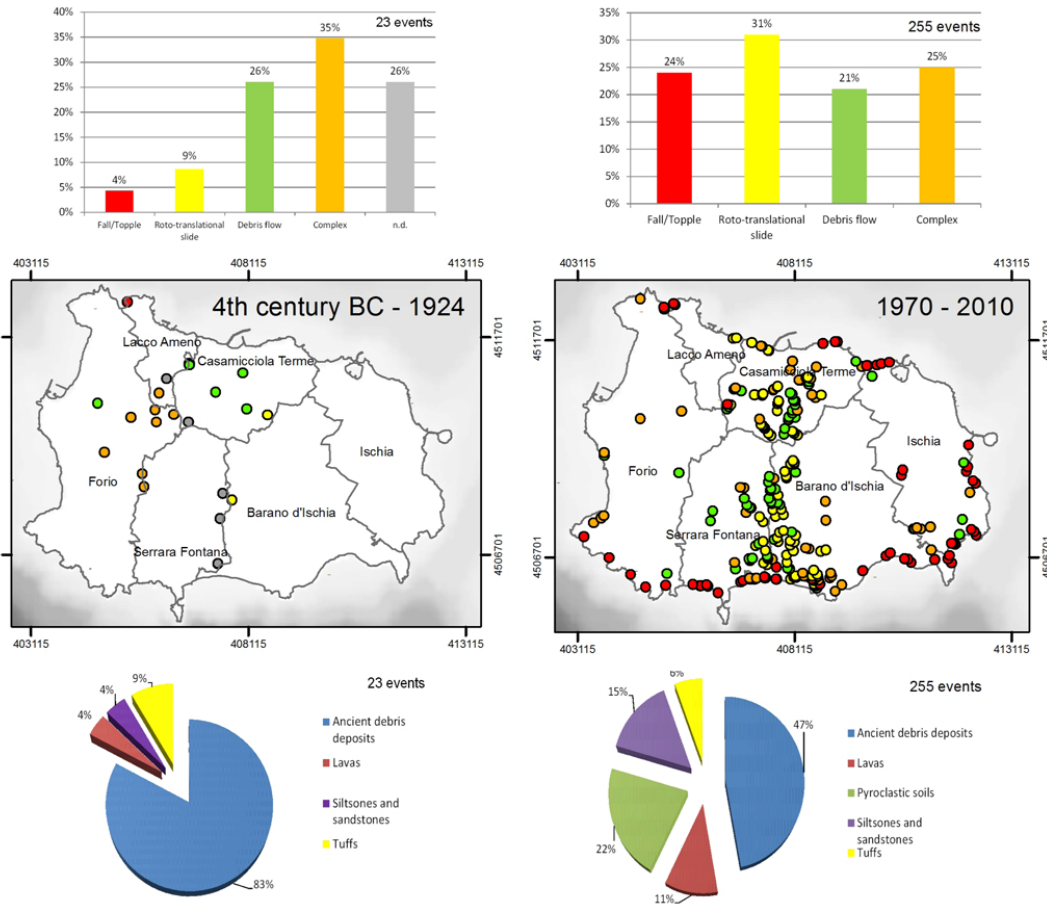
Fig. 11. Temporal distribution of the terrestrial landslides in the island of Ischia. Histograms = landslide types; pie-charts = lithologies involved (n.d. =